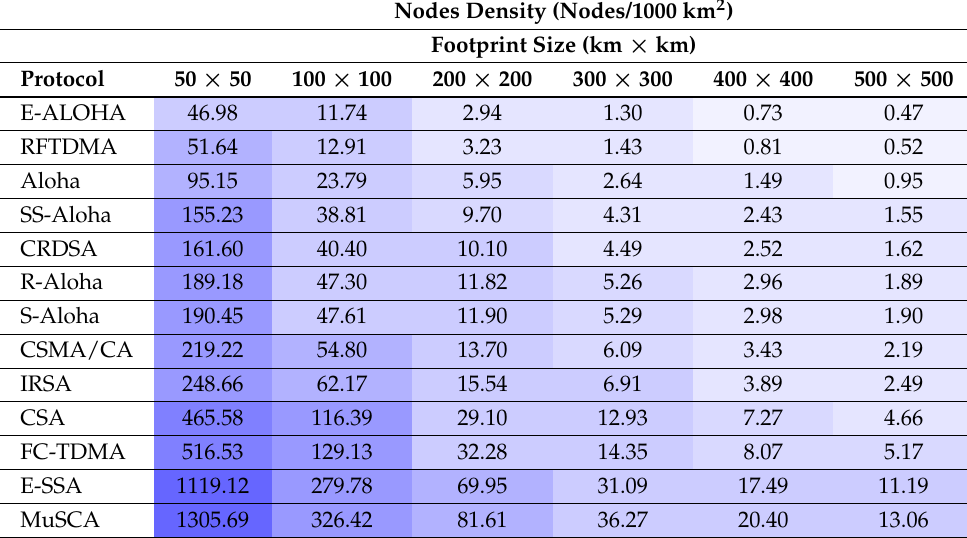
Table 5. Density of nodes for each MAC protocol for applications that send 38 symbol